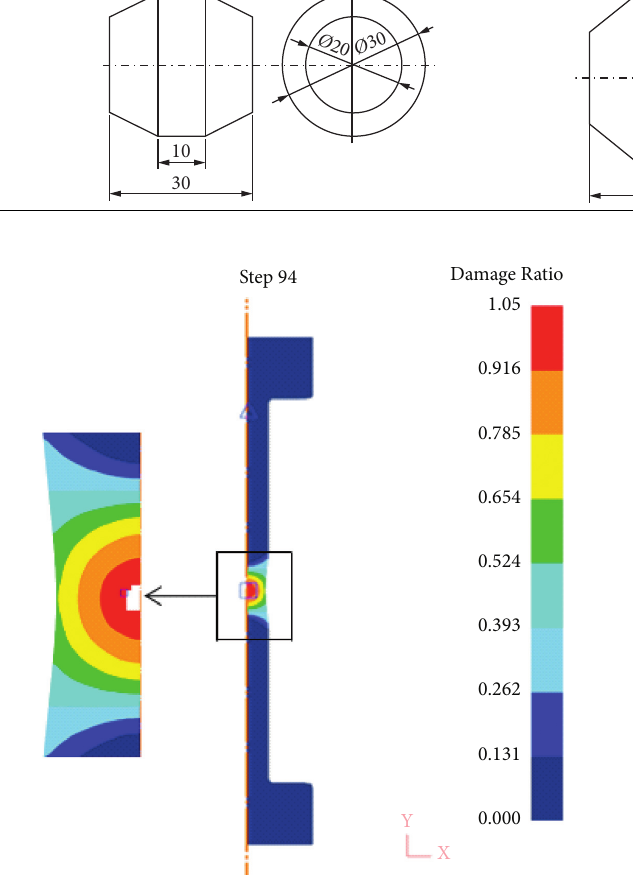
Figure 7: Schematic diagrams of the rupture location based on the numerical simulation using the developed ductile fracture criterion for as-cast 42CrMo steel at 1373K and 0.1s − 1 .